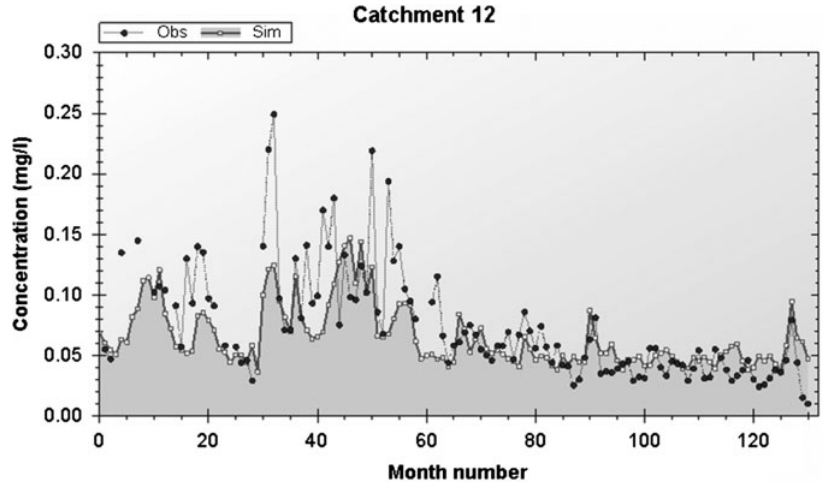
Fig. 7. Modeled and observed total phosphorus concentrations in FyrisNP